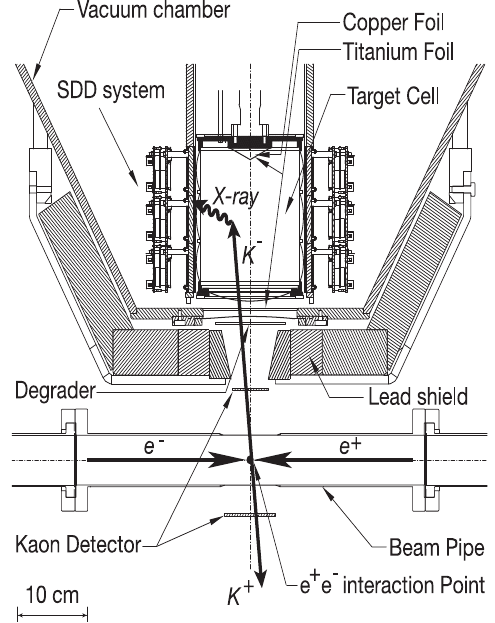
Figure 5: Scheme of the SIDDHARTA setup [ 36 ]